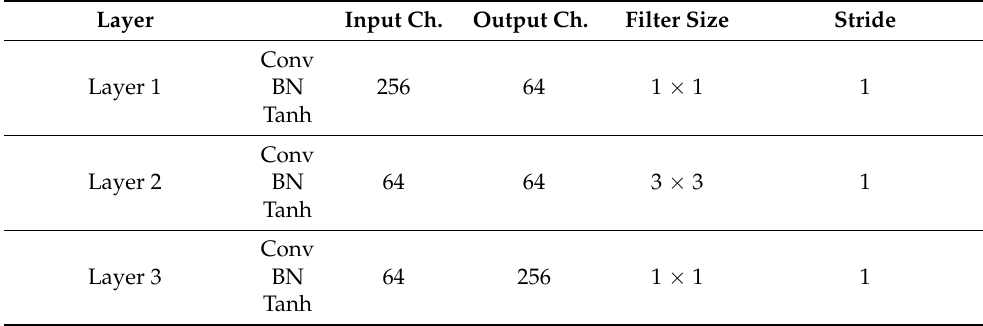
Table 1. Bottleneck residual module network structure.